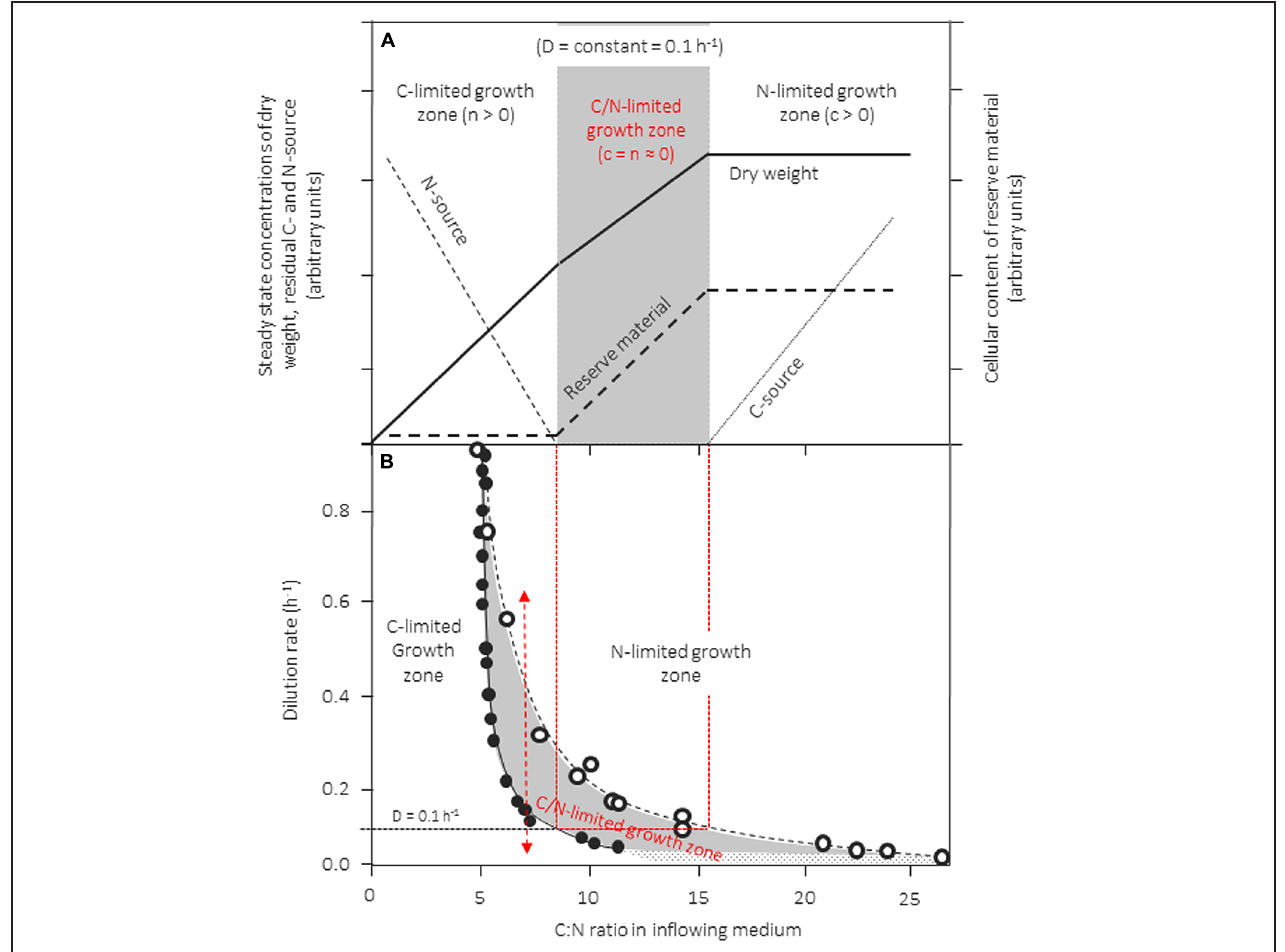
FIGURE 3 | Zones of single- and dual-nutrient-limited growth (gray area) for a culture of Klebsiella pneumoniae cultivated in the chemostat as a function of dilution rate and C:N-ratio in the feed medium. (A) Conceptual scheme of residual steady-state concentrations for the nitrogen (ammonia) and the carbon source (glycerol) at a dilution rate (D) of 0.1 h − 1 , as well as the steady-state biomass concentration in the culture and of an accumulated reserve material. In this experiment, the concentration of the nitrogen source in the feed medium is kept constant and the C:N-ratio